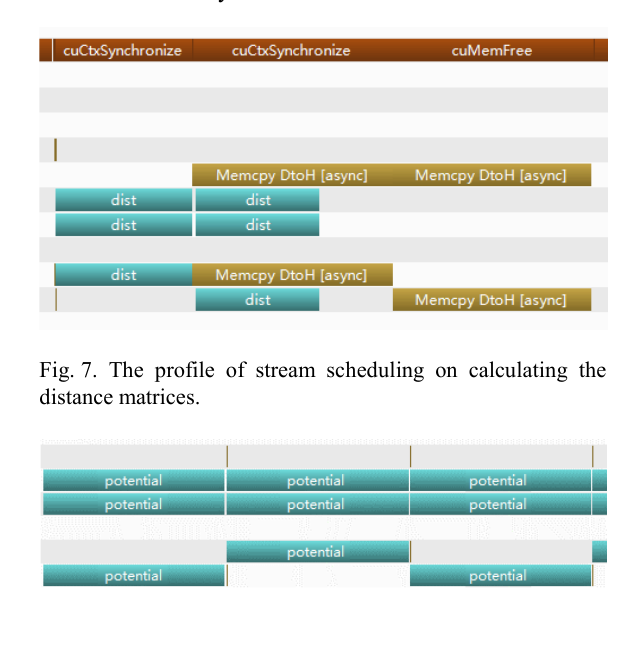
Fig. 5. Performance of calculating the distance matrix.